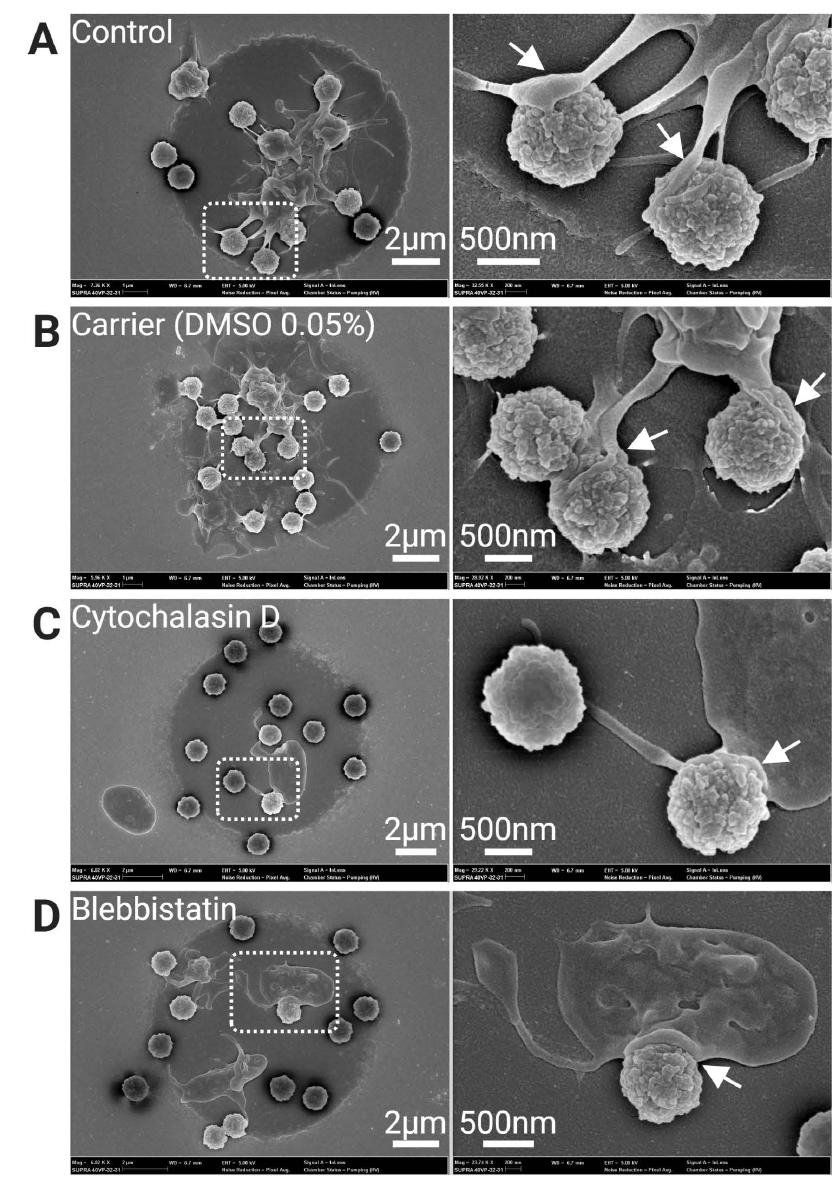
Figure 4. Scanning electron microscopy (SEM) of platelets interaction with Agg-IgG coated bacteri- amimetic microbeads on micropattern. In controls ( A , B ), platelets can be seen adhering and spreading on the Agg-IgG beads. Extensive filopodia and membranous lamellipodia (indicated arrowheads) are visible in control platelets but not in platelets treated with cytoskeletal inhibitors Cytochalasin D and Blebbistatin ( C , D